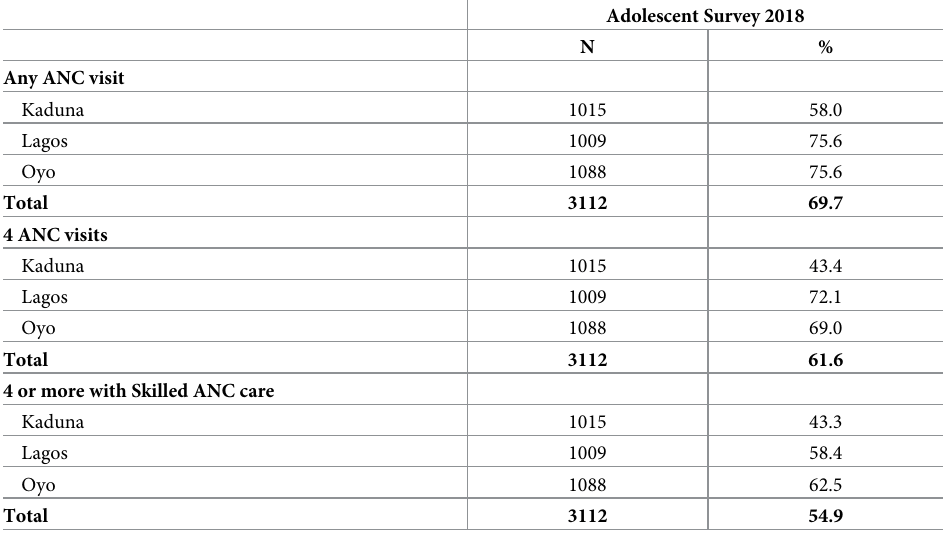
Table 2. Percentage of adolescent mothers having at least 4 ANC